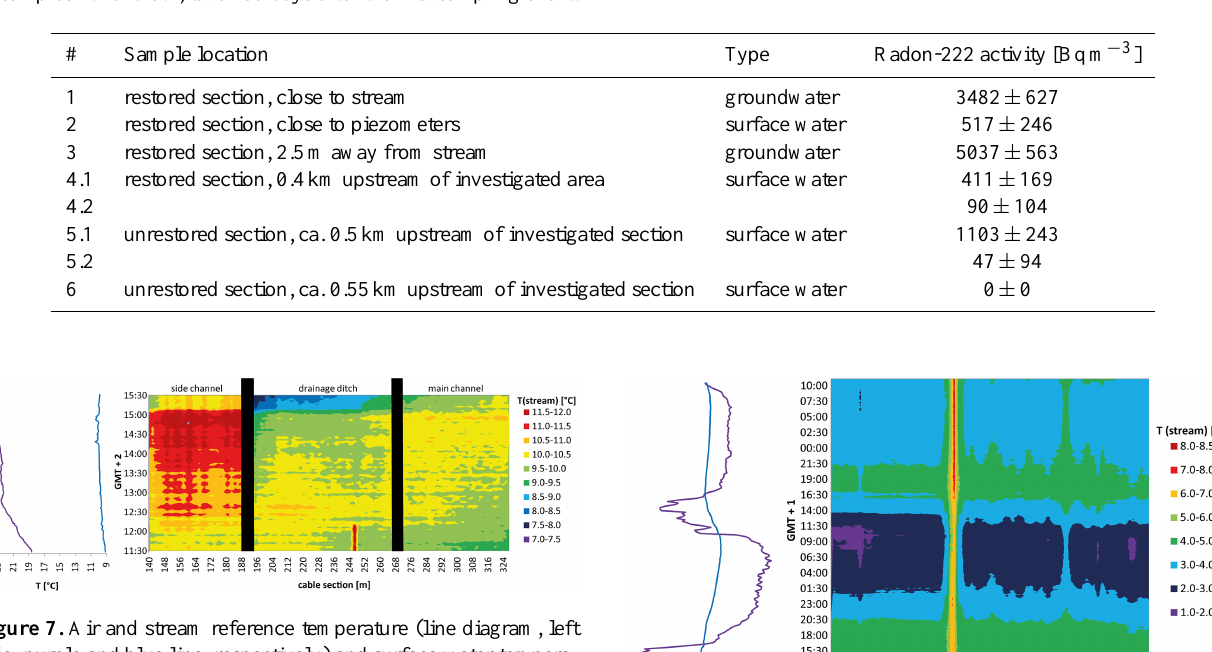
Table 1. Radon-222 activities in Bq/m 3 in groundwater and surface water samples from the Chriesbach. Samples 4.2 and 5.2 are replicates of samples 4.1 and 5.1, taken 39 days after the first sampling event.